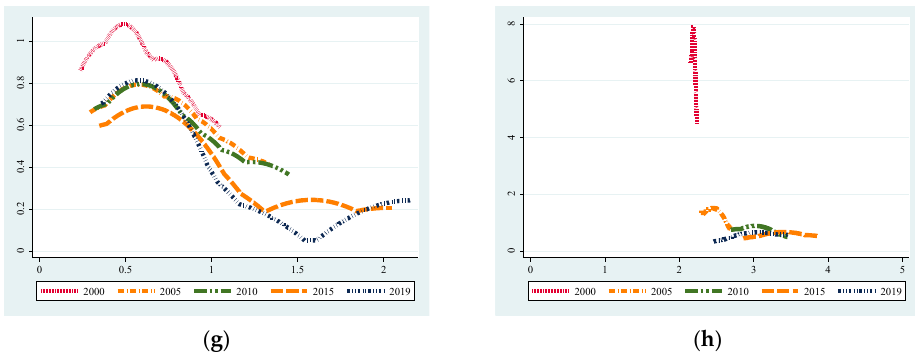
Figure 5. Nucleus density curves of agriculture induced N 2 O emissions in economic zones ( a ) North Coast economic zones ( b ) East Coast economic zones ( c ) South Coast economic zones ( d ) Middle Reaches of the Yellow River economic zones ( e ) Middle Reaches of the Yangtze River economic zones ( f ) Great Southwest economic zones ( g ) Great Northwest economic zones ( h ) Northeast economic zones.